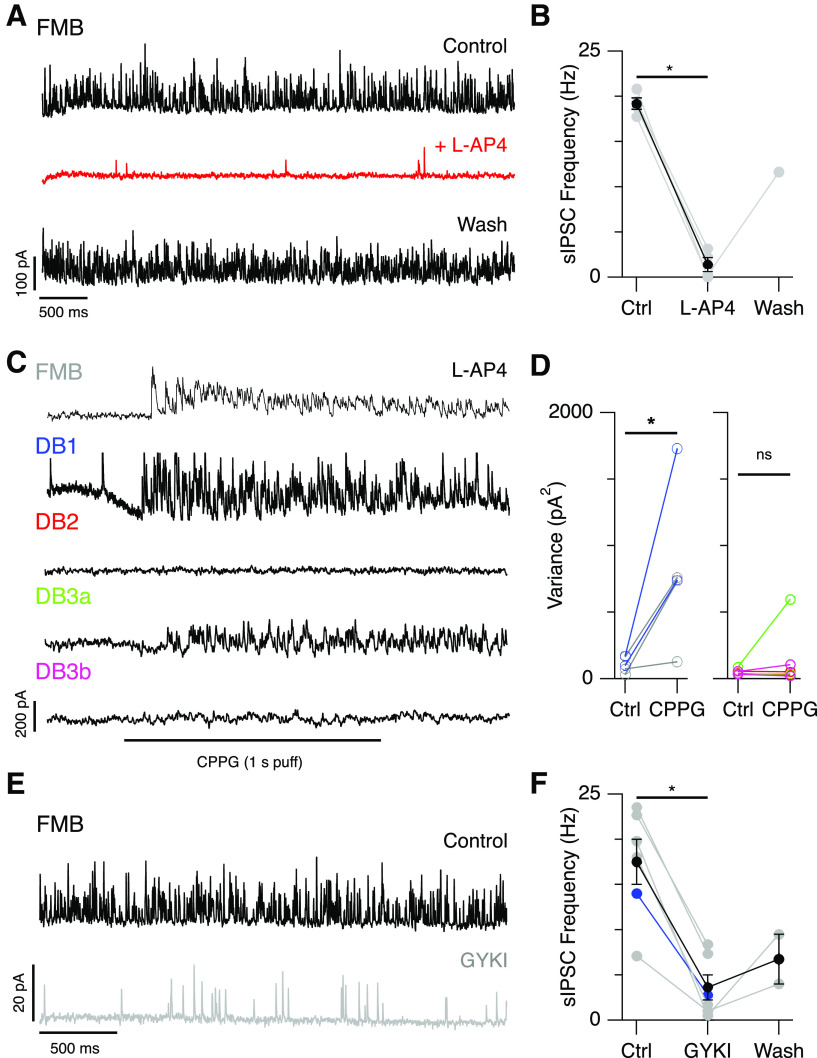
Inhibitory input to Off-CBCs is driven by the On-pathway. A, Example traces showing sIPSCs in an FMB cell before, during, and after bath-application of L-AP4 (10 μm). B, Effect of L-AP4 on sIPSC frequency for a group of FMB cells (Ctrl and L-AP4; n = 4 cells, washout; n = 1 cell, *p = 0.028, Wilcoxon test). Gray points represent individual cells, black points show mean ± SEM. C, Example traces showing effect of puffing CPPG (600 μm) in the OPL in the presence of bath-applied L-AP4. CPPG puffs increase the frequency of sIPSCs in FMB, DB1, and DB3a cells but not in DB2 and DB3b cells. D, Plots showing current variance before and after puff application of CPPG in the presence of L-AP4 for FMB/DB1 cells (left panel) and DB2/DB3a/DB3b cells (right panel). Data are from n = 3 FMB (gray), n = 2 DB1 (blue), n = 3 DB2 (red), n = 2 DB3a (green), and n = 2 DB3b (magenta); *p < 0.05 Wilcoxon rank test. Current traces in A, C are at a step to 0 mV. E, Example traces showing reduced frequency of sIPSCs in an FMB cell after bath application of the AMPA receptor antagonist, GYKI-53655 (10 μm). Holding potential is −60 mV. F, Effect of GYKI on sIPSC frequency for a group of five FMB cells (gray points) and one DB1 cell (blue point). Partial washout was obtained in n = 2 FMB cells; *p = 0.016 with Wilcoxon rank test. Black points show mean ± SEM.